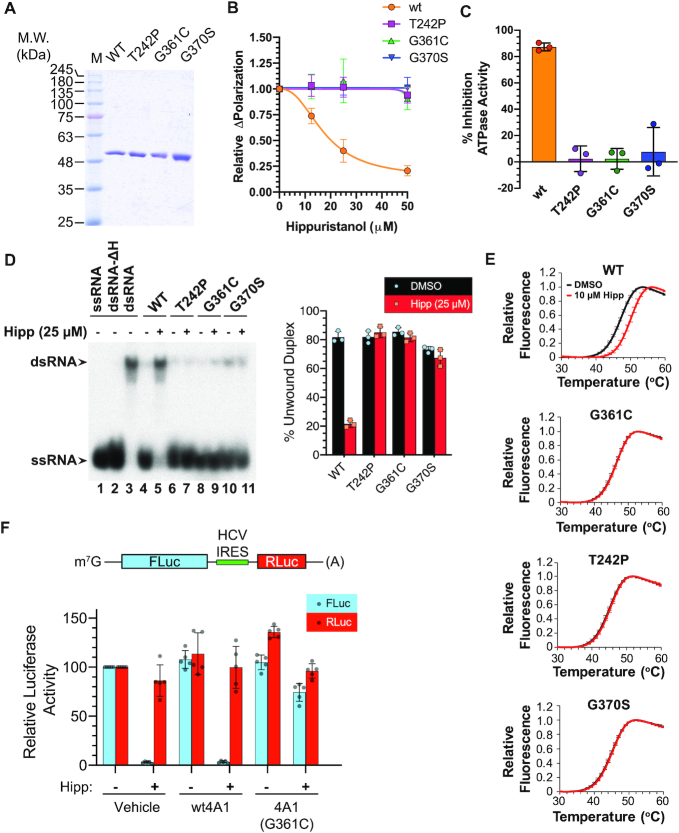

In vitro characterization of EIF4A1 HippR mutations. (A) Coomassie-stained 10% polyacrylamide gel of purified recombinant eIF4A1 proteins. (B) RNA-binding activity of EIF4A1 allelic variants. Poly r(AG)8 RNA was incubated in the presence of 1 μM recombinant protein and either vehicle (0.1% DMSO) or Hipp for 30 min prior to measurements. The change in FP in the presence of Hipp relative to vehicle control is presented. n = 3 ± SD. (C) Response of ATPase activity of wt and HippREIF4A1 variants to 50 μM Hipp. n = 3 ± SD. (D) Helicase activity of EIF4A1 HippR variants in the presence or absence of Hipp. Left panel: The position of migration of the double-stranded (ds) RNA duplex and single-stranded (ss) RNA molecules is indicated by arrows to the left of the panel. dsRNA-ΔH: migration of radiolabelled RNA following heat denaturation of dsRNA substrate at 95°C for 5 min. Right panel: Quantification of three experiments is provided to the right. n = 3 ± SD. (E) DSF analysis of EIF4A1 allelic variants in the presence or absence of Hipp. n = 3 ± SD. (F) Rescue of Hipp-mediated inhibition of translation by eIF4A1(G361C). Top panel: Schematic of bicistronic mRNA used in these studies. Bottom panel: Recombinant protein (850 ng) was added to RRL translation reactions (10 μl) containing vehicle (0.5% DMSO) or 5 μM Hipp. Reactions were incubated at 30°C for 60 min, after which firefly (FLuc) and renilla (RLuc) luciferase readings were taken. n = 3 ± SD.